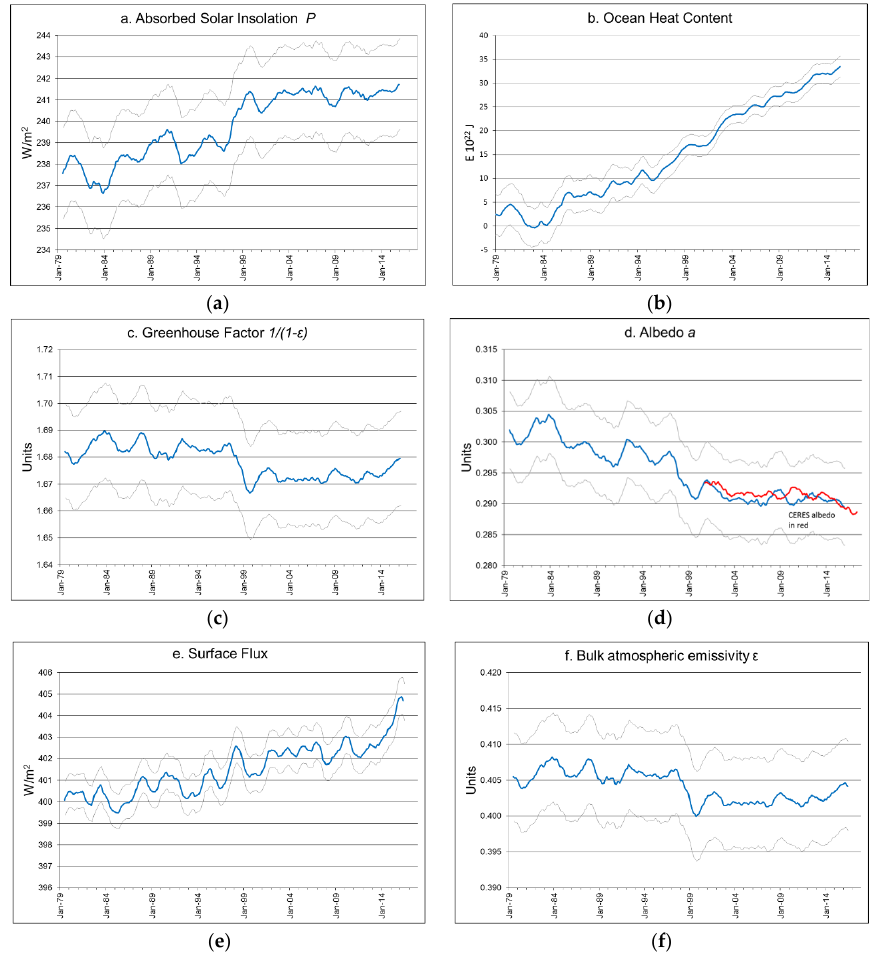
Figure 7. Center-averaged 12 monthly values for the period 1979–2015 for ( a ) absorbed solar insolation P ; ( b ) ocean heat content relative to 1958–1962 base period; ( c ) greenhouse factor; ( d ) bond albedo, with Clouds and Earth’s Radiant Energy System (CERES)-derived albedo in red; ( e ) surface flux; and ( f ) bulk atmospheric emissivity. Grey lines in ( a , c , d , f ) derived from the 2 W/m 2 accuracy estimate of the HIRS 2.2. Absorbed solar insolation and surface flux graphs both show 10 W/m 2 range over their y -axes.